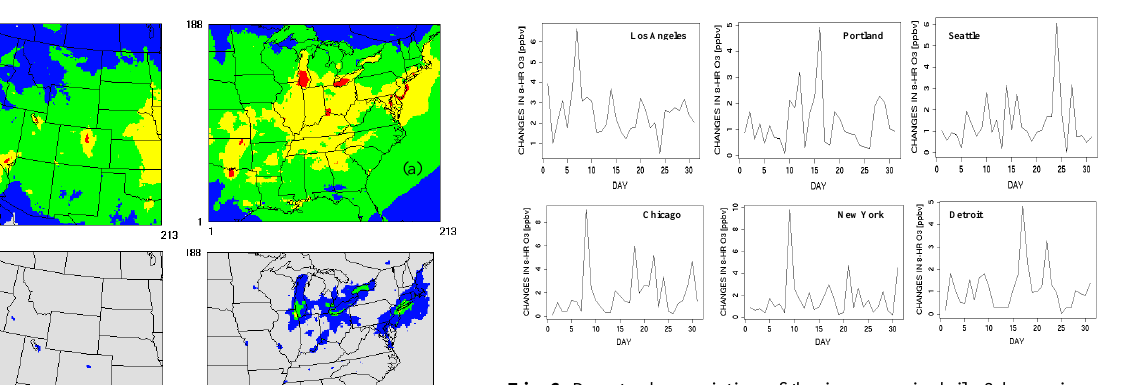
Fig. 6. Day-to-day variation of the increases in daily 8-h maximum O 3 in selected